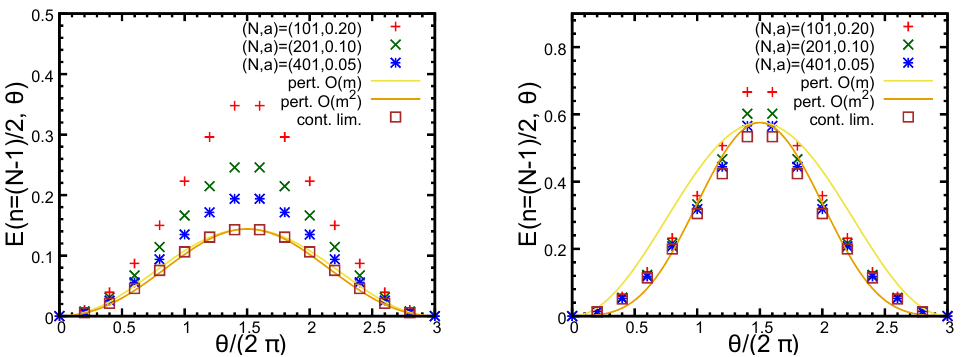
Figure 3 . The local energy density E ( n, θ ) at the center n = ( N − 1) / 2 as a function of θ . Square symbol in each panel denotes the results taken the continuum extrapolation. The mass parameter from left to right panel is m lat = 0 . 15 and 0 . 60 , respectively, and we compare the results with the O ( m ) and O ( m 2 ) mass